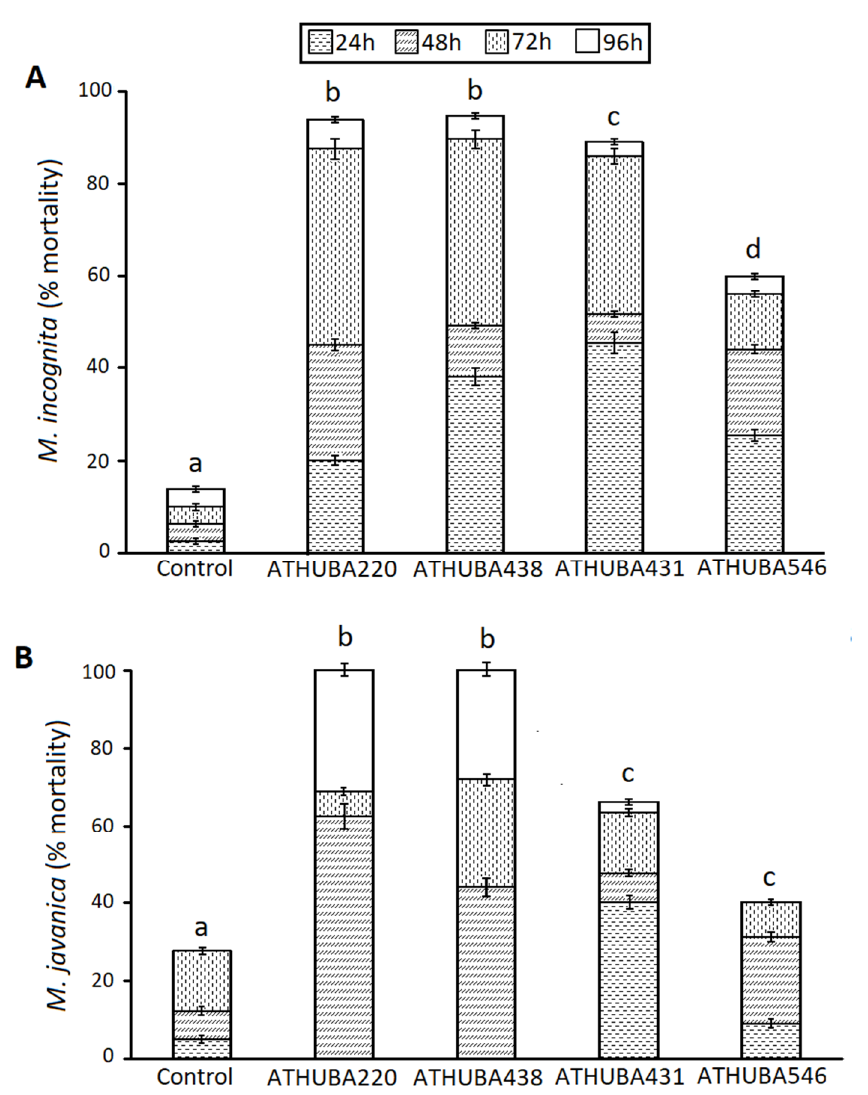
Figure 2. Percentage (mean± standard error) of J2 mortality in M. incognita ( A ) and M. javanica ( B ) after 96 h of immersion into solvent extracts from different Streptomycetes solid cultures as depicted. The control wells contained 70 μl of J2 s suspension. Different letters above columns correspond to statistically significant differences between treatments (one-way ANOVA, Tukey’s test at p < 0.05; for all cases n = 15–20).